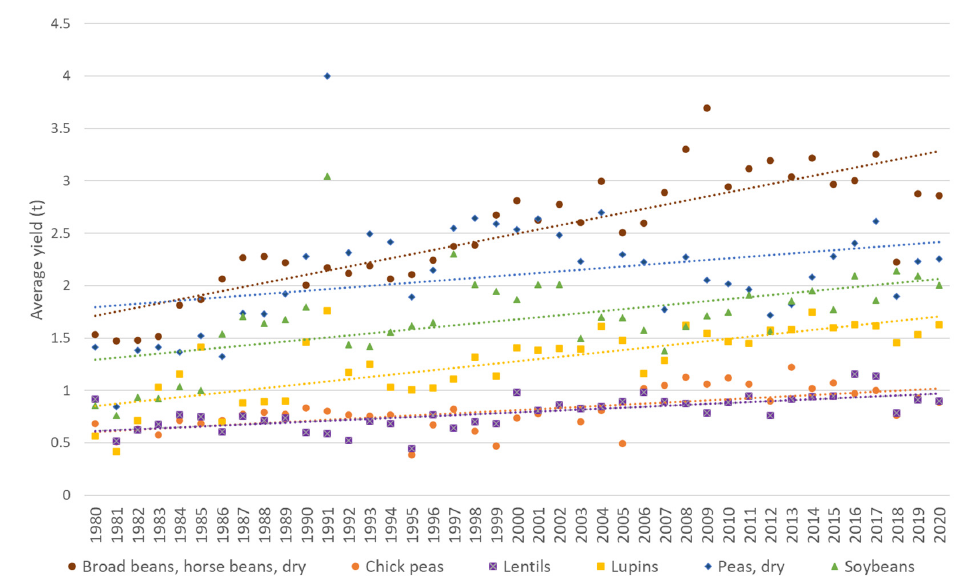
work. The most significant rise is experienced in the case of soybean.